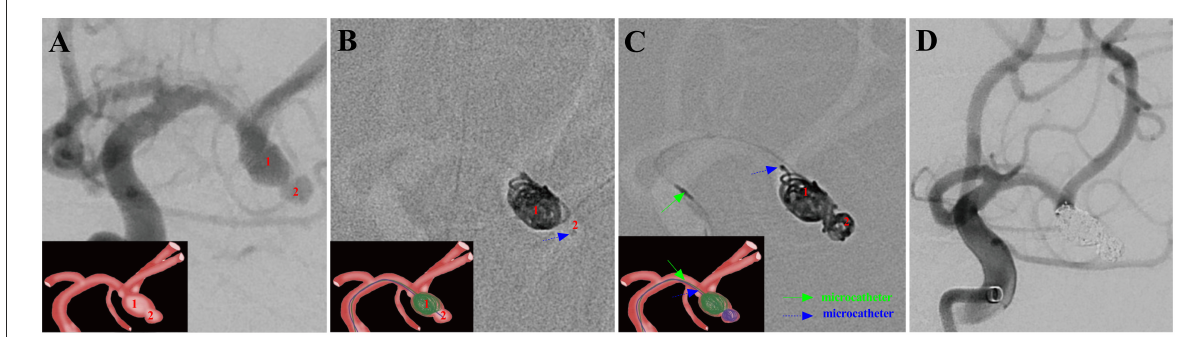
FIGURE3 A ruptured right MCA aneurysm (Hunt-Hess grade II) in a 46-year-old female was treated using the MCP technique. Arabic numerals indicate the ascus of an IA. (A) Right ICA DSA (working angle) displayed a gourd-like irregular aneurysm with a daughter sac at the MCA. (B) Dual microcatheters were introduced in the IA sac. Embolization was performed with a microcatheter (blue arrow) navigating into the upper daughter sac and coils packing (image of digital non-subtraction angiography). (C) After packing the upper sac, the lower daughter sac was coiled via the other microcatheter (green arrow). (D) The working angle view of postoperative embolization showed complete occlusion of MCA aneurysm (Raymond grade I).